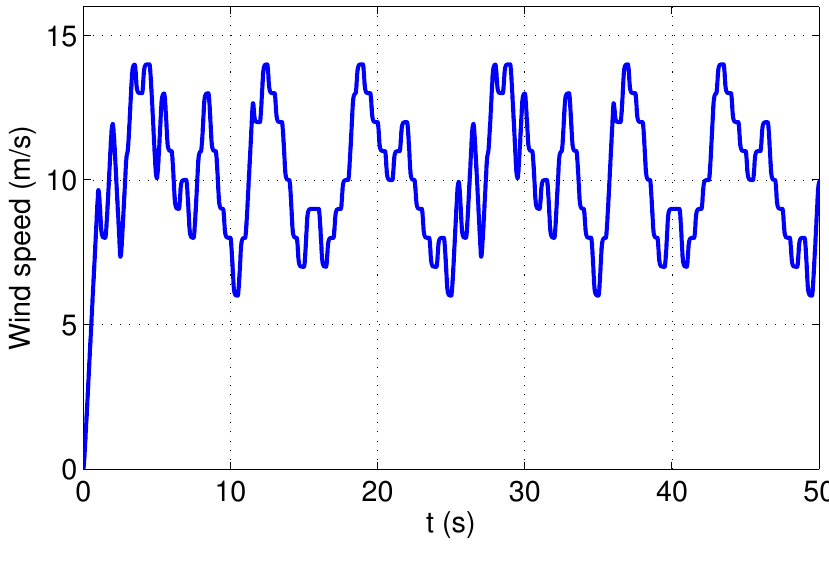
Figure 5. Wind speed profile for test purposes.